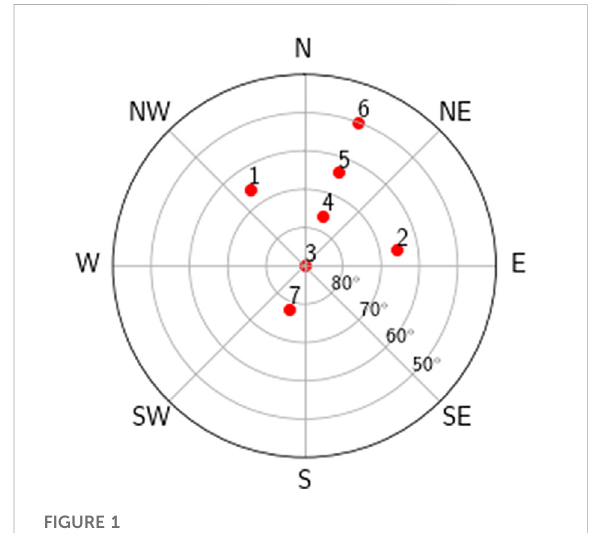
FIGURE 1 The orientation of PFISR ’ s 7-beam TopsideUp fl ow2 observing mode (in geographic coordinates). NotethatPokerFlathasamagneticdeclinationof16 ° .Beams1and 2 are pointed northwest and northeast respectively to allow for estimation of vector velocities. Beams 3 through 7 fan out in a plane of constant magnetic longitude. Beam 7 is oriented along the local magnetic fi eld line (towards magnetic